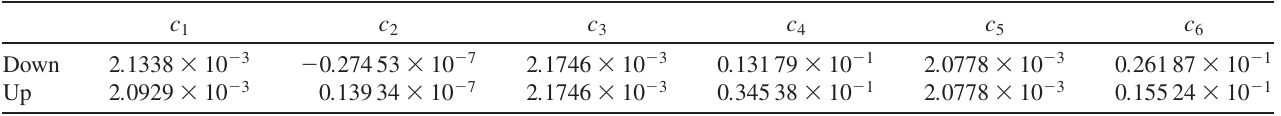
TABLE IV. Parameters of the approximation for the magnetic induction at the source